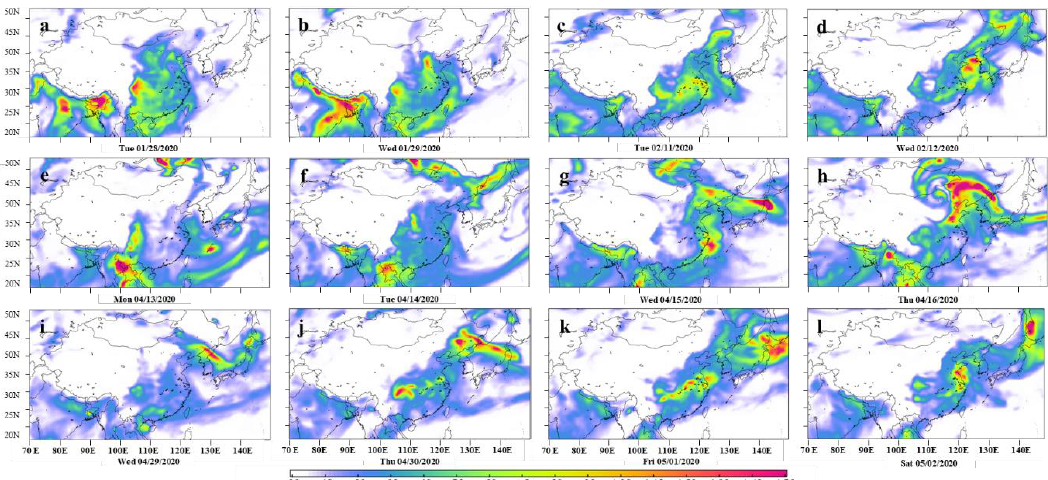
Figure A1. Daily variation of O 3 -1 h extreme range and O 3 -MDA8 2018 – 2019. Note: data missing from 22 to 26 December 2018 (replaced by average).